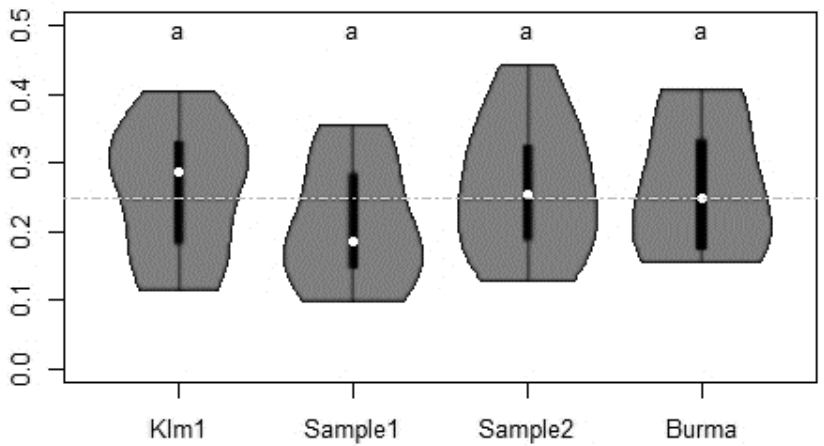
Figure 4. Proportion of stable flies captured by different blue screens during the experiment 2 (16 August to 5 September). The total numbers of stable flies caught per trap were: 9641 (KLM1); 8356 (Sample 1); 10,592 (Sample 2) and 10,699 (Burma). See Figure 3 for explanations about the violin plots.